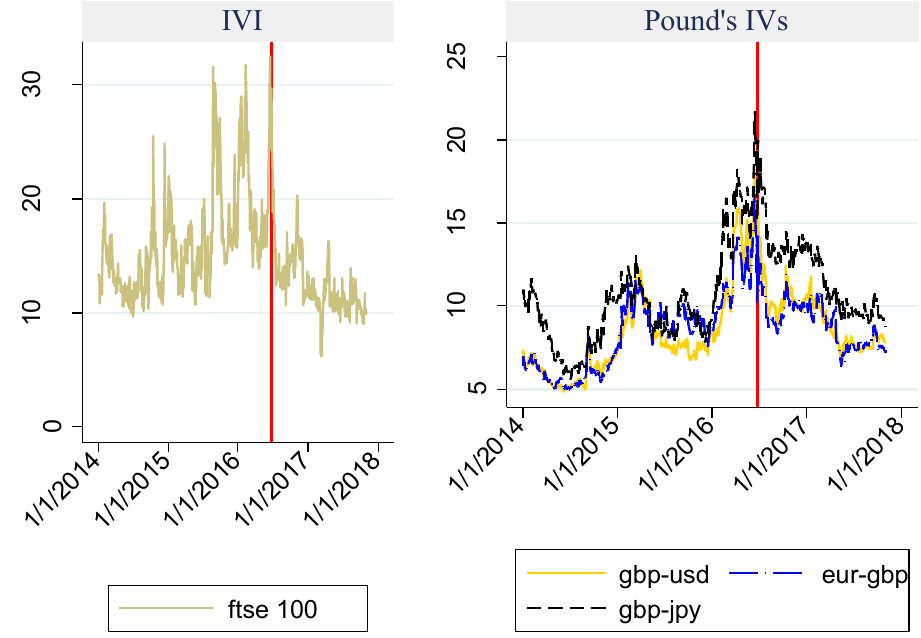
Figure 1. The Implied Volatility Index (IVI) and British pound’s IVs. The vertical red line corresponds to 23 June 2016, the date of the Brexit referendum.